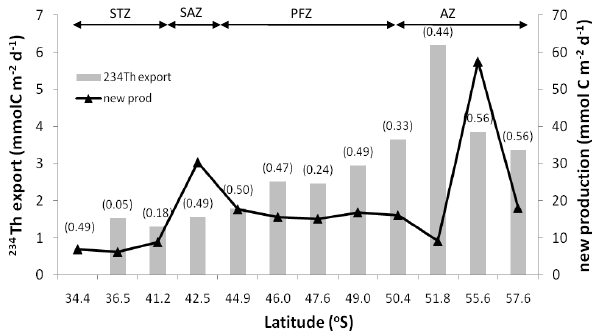
Figure 6. Comparison between 234 Th carbon export (at 100 m) (grey bars) and „new 863 Fig. 6. Comparison between 234 Th carbon export (at 100m) (grey production‟ estimates (black triangles) in units mmol C m -2 d -1 during BGH. f -ratio is 864 bars) and “new production” estimates (black triangles) in units indicated in brackets. New production calculated from ∫ ρ NO 3 and the C:N ratio. It shows the 865 difference in magnitude of these proxies of carbon export. 234 Th data from Planchon et al, 866 mmol Cm − 2 d − 1 during BGH. f -ratio is indicated in (2011). Latitudes for the different zones are STZ (34 – 42.2 o S), SAZ (42.2 – 44.2 o S), PFZ 867 (42.2 – 50.1 o S) and the AZ (50.1 – 57.5 o S). 868